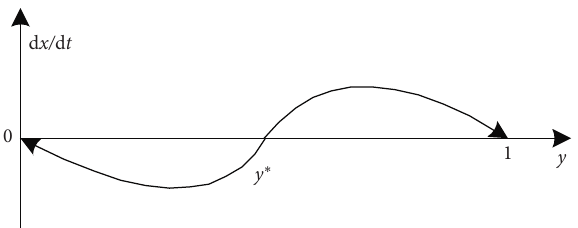
− β l ) / ( α C − λ l )) . 2 2 2